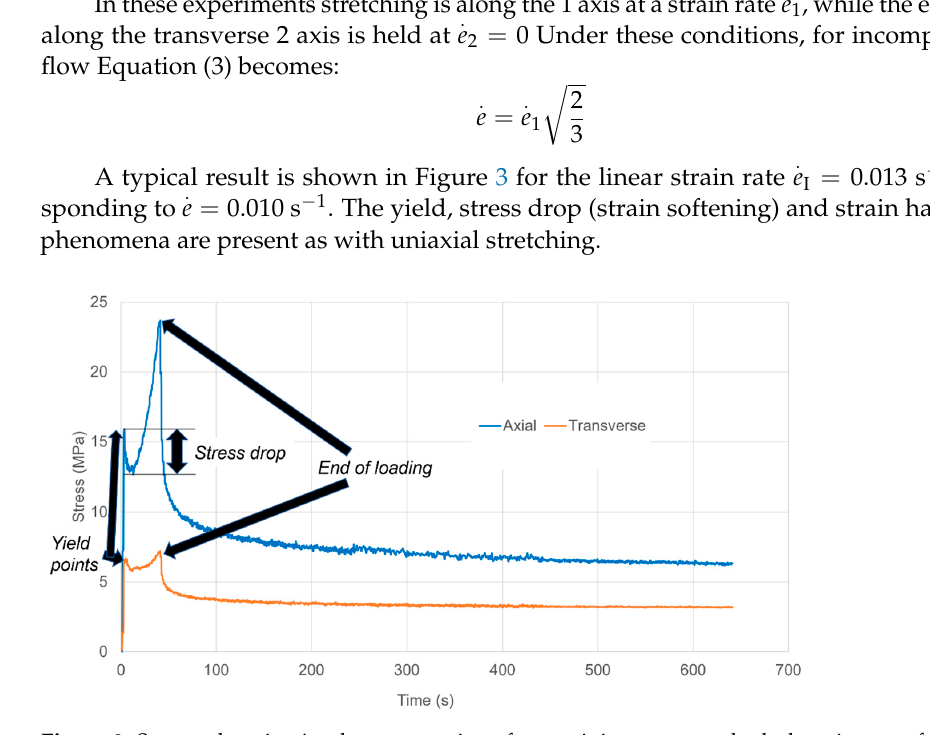
( b ) Figure 4. Axial ( a ) and transverse ( b ) true stresses for loading and stress relaxation in planar exten- sion. They key shows octahedral strain rates in s − 1 .